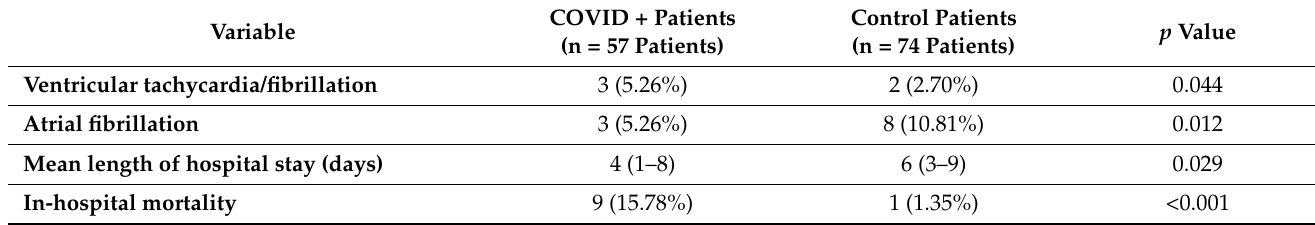
Table 6. In-hospital outcomes and length of hospital